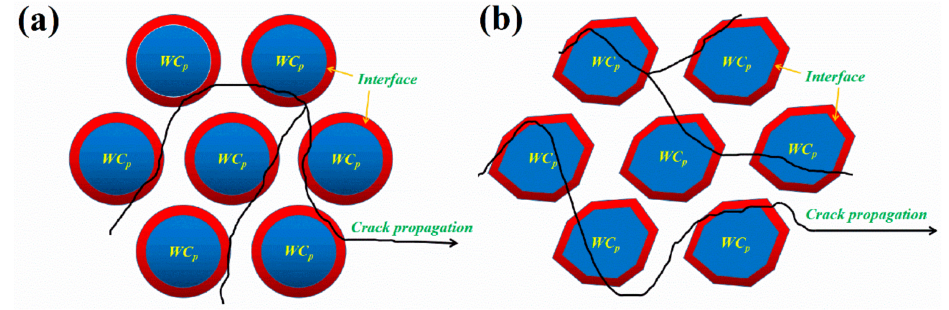
Figure 7. The crack propagations simulation diagram of WC p /iron matrix composites with different particle shape: ( a ) Spherical particle; ( b ) Irregular